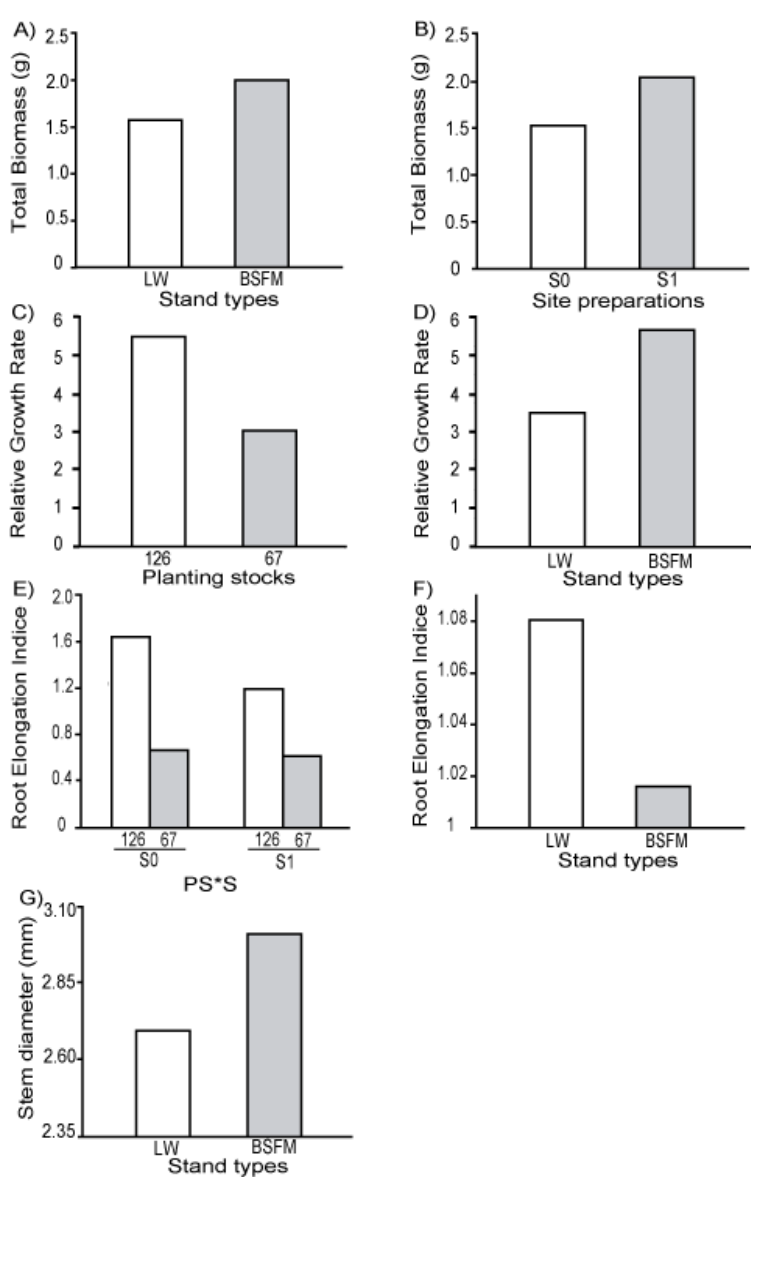
Figure 2. Stand types, site preparation (S) and planting stock (PS) size effects on the ( A , B ) total dry mass, ( C , D ) relative growth rate, ( E , F ) Root Elongation Index and ( G ) stem diameter of containerized black spruce seedlings planted in lichen woodlands and black spruce feather-moss stands, one year after plantation ( n = 72 ( A – D , F , G ), n = 18 ( E